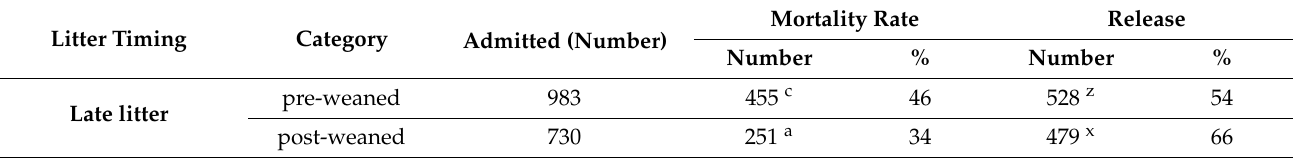
Table 1. Outcome of juvenile European hedgehogs admitted to wildlife rehabilitation centres from 2011 to 2020 divided into four categories by weight and timing of litter (data are from the 3441 individuals with known outcome) .